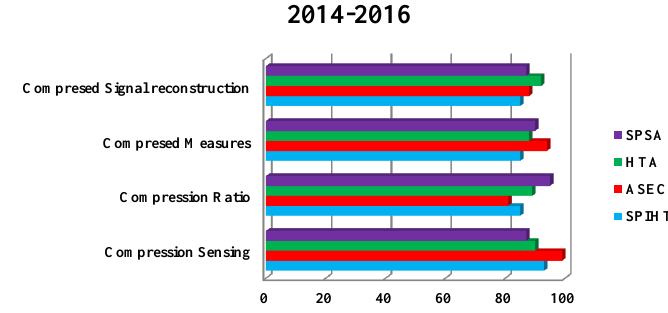
Figure 3: Graphical representation of 2014-2016 review results